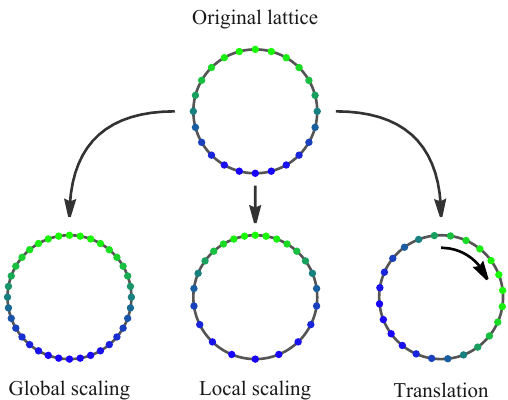
Figure 7 . Visualization of symmetry transformation of a CFT ground state with periodic boundary conditions on a regular discretization: while translations and local (non-uniform) scale transforma- tions merely distort the lattice under constant number of discretization points, global (uniform) scale transformations change its resolution and are thus equivalent to a renormalization group (RG) transformation. Figure adapted from ref.